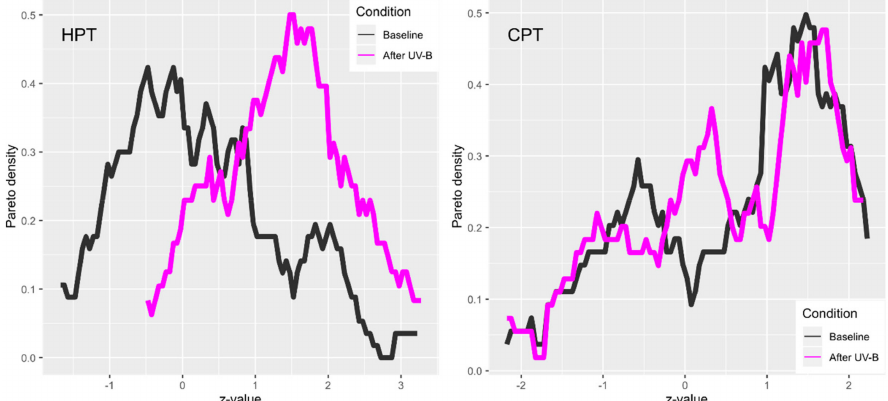
Figure 1. Distribution of the z-values of the quantitative sensory testing parameters heat pain threshold (HPT) and cold pain threshold (CPT), acquired at baseline (black) and following hypersensitization using the topical application of UV-B (violet). The density distribution is presented as probability density function (PDF), estimated by means of the Pareto Density Estimation (PDE [23]), as implemented in the R package “DataVisualizations” (https: // cran.r-project.org / package = DataVisualizations [24]). Higher z-scores indicate a higher sensitivity to the respective stimuli. The figure has created using the R software package (v. 3.6.2 for Linux; http: // CRAN.R-project.org / [25]) and the libraries “ggplot2” (https: // cran.r-project.org / package = ggplot2